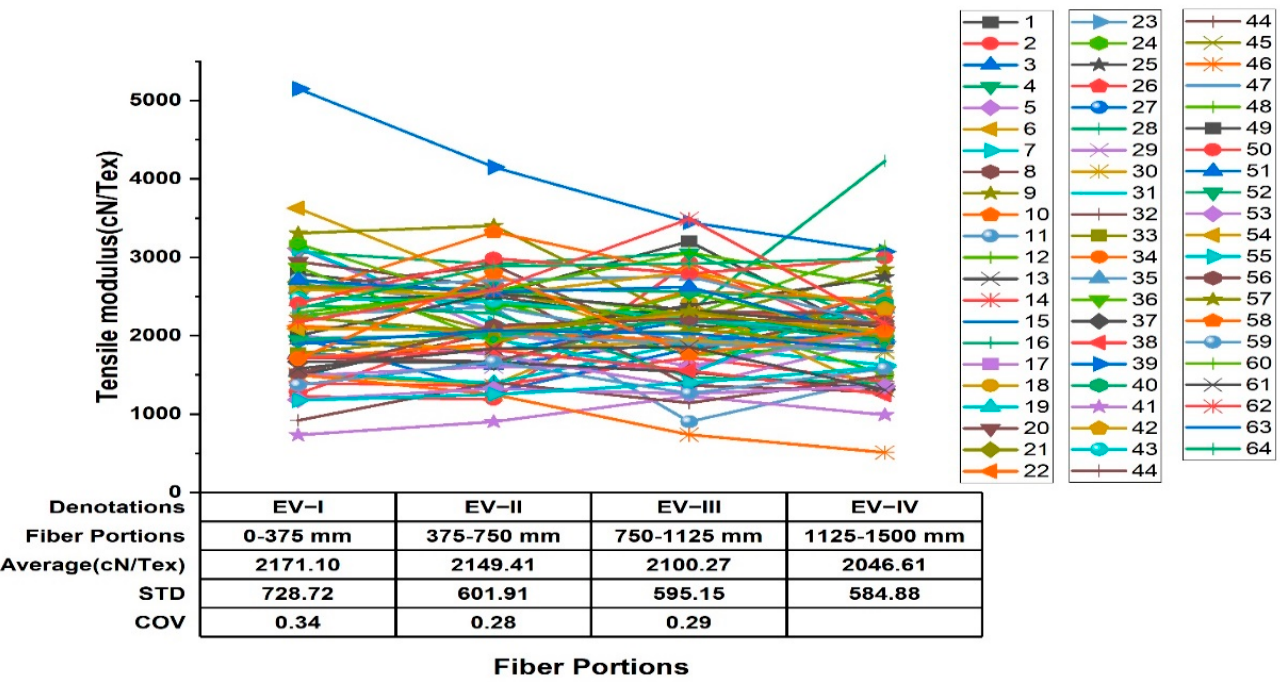
Figure 5. Fiber sections versus tensile modulus.